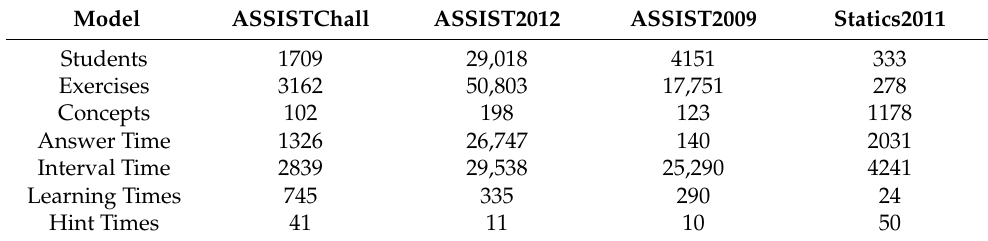
Table 2. Details of all